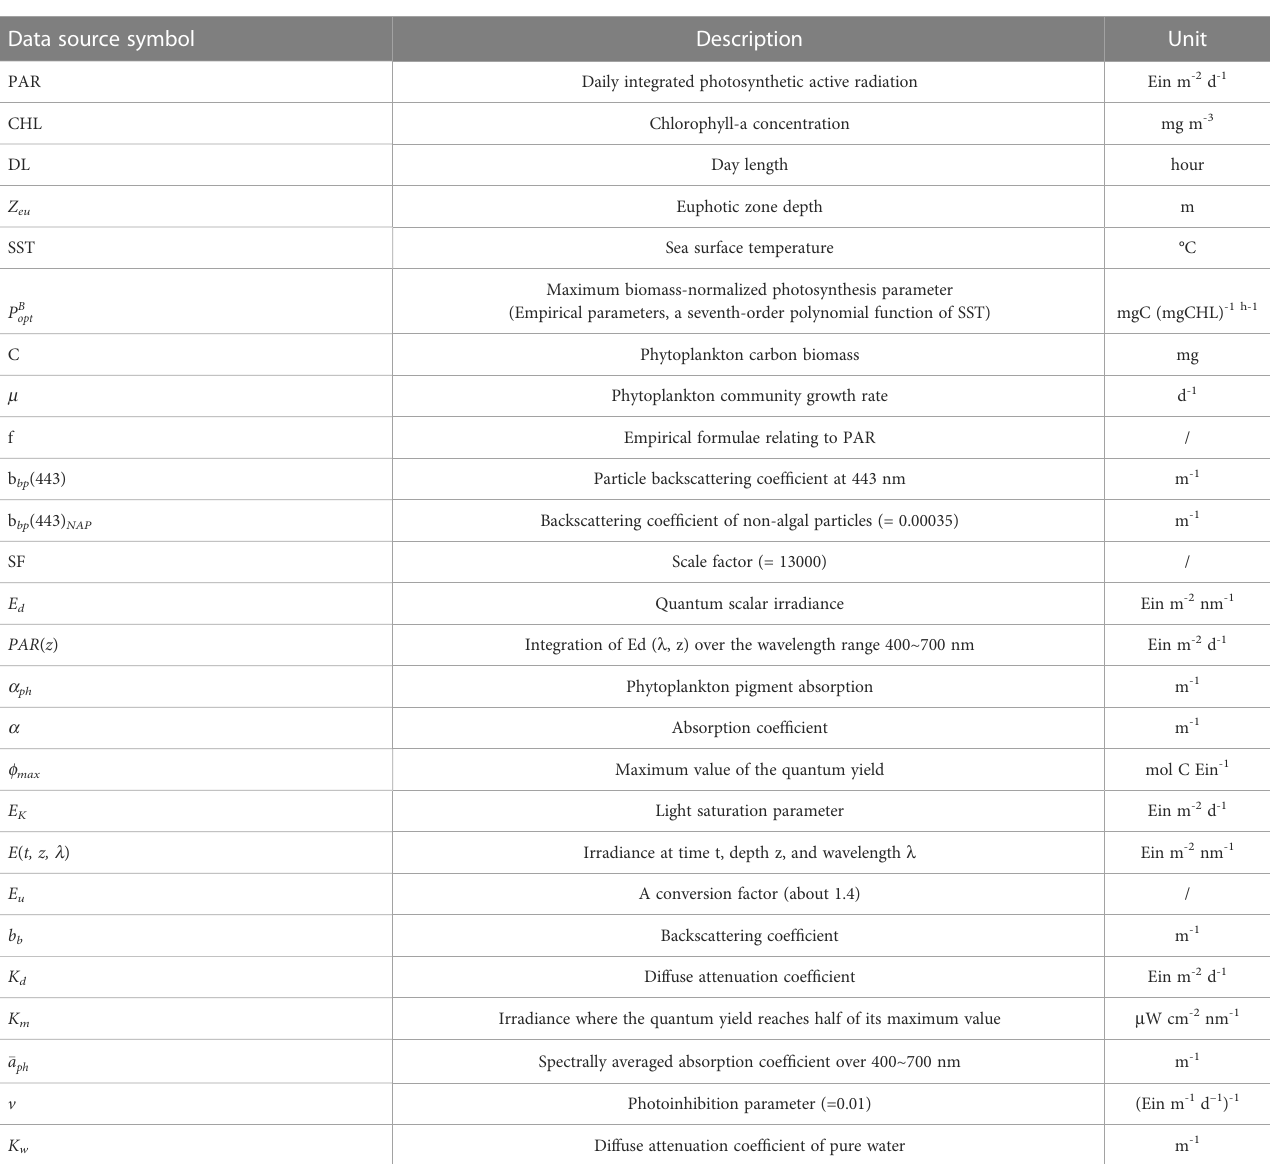
TABLE 2 List of Symbols. Data source